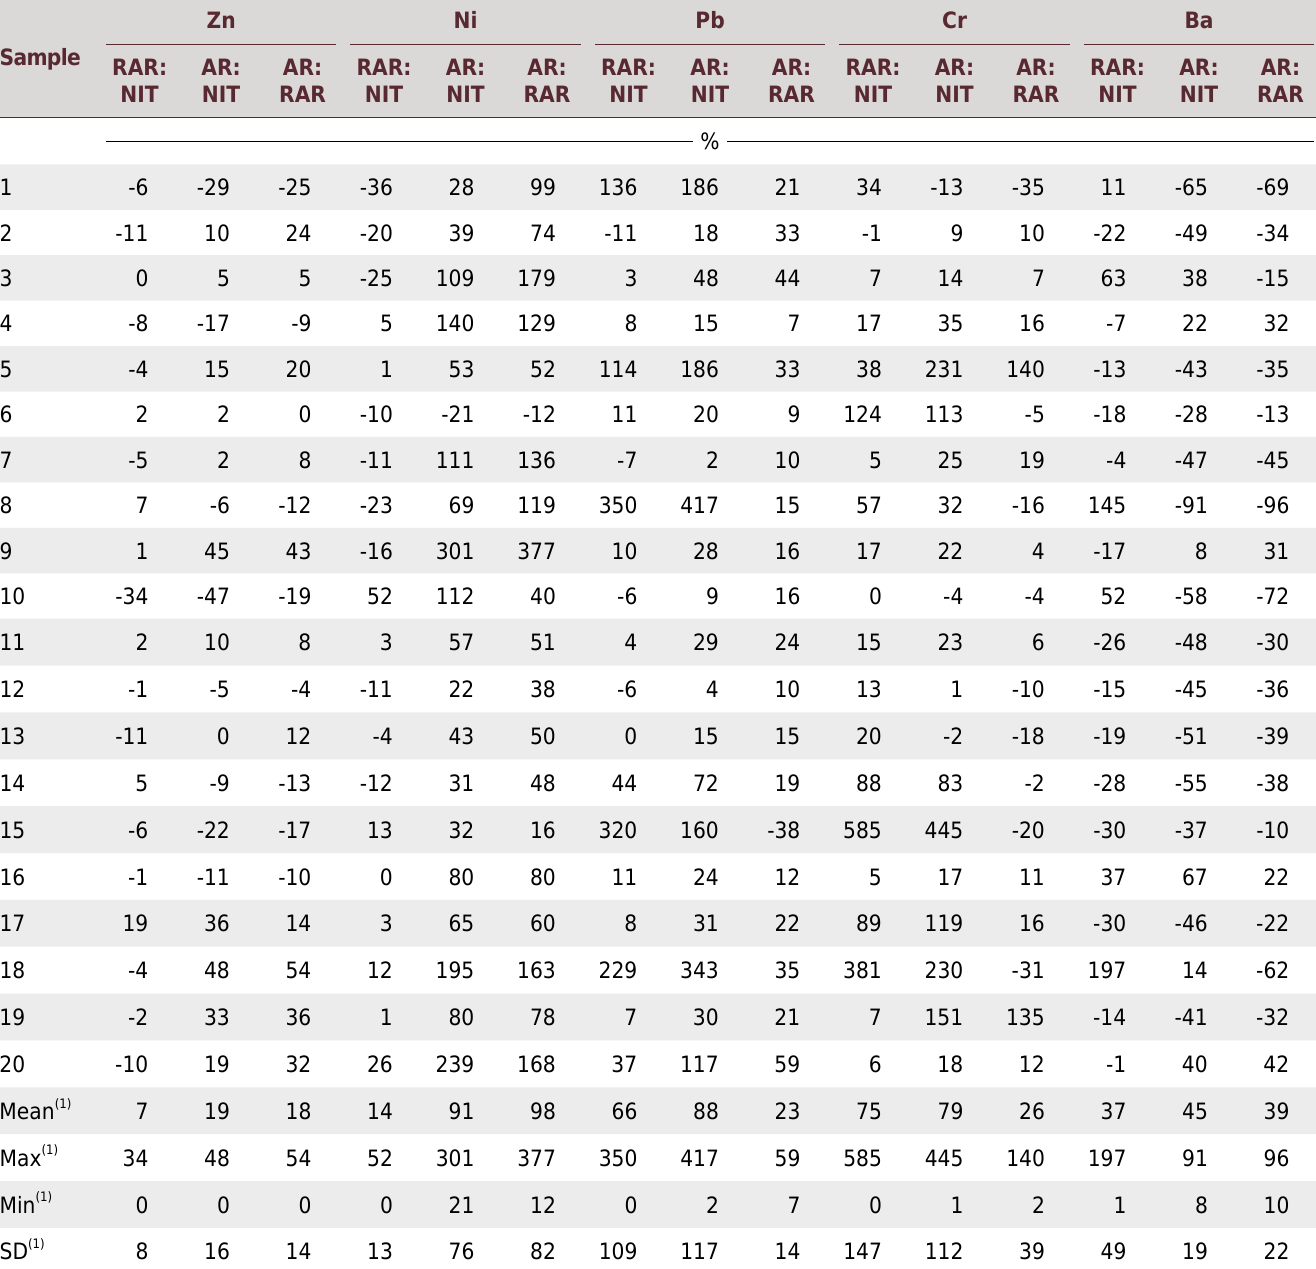
Table 5. Variation rates among digestion methods EPA 3051, EPA 3051A and Aqua Regia obtained in the different organic